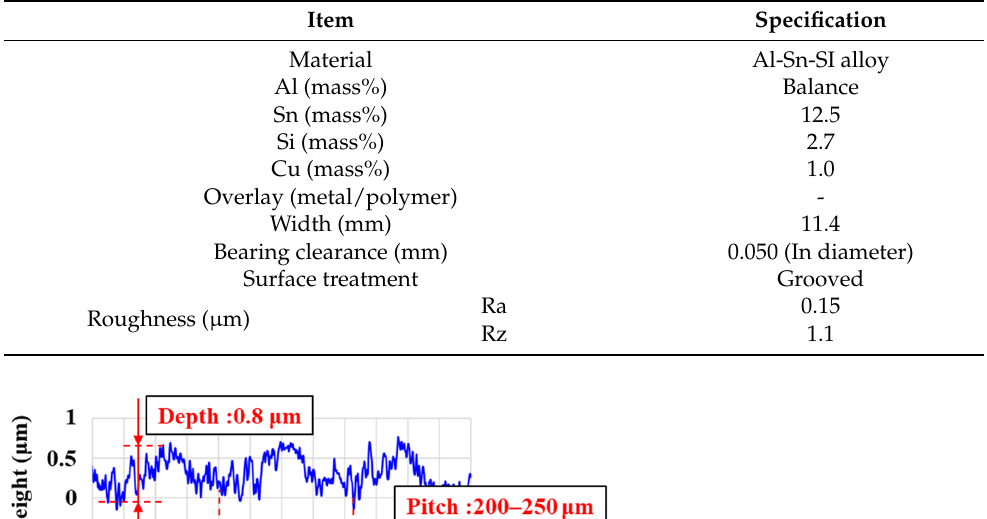
Table 5. Main bearing specifications.